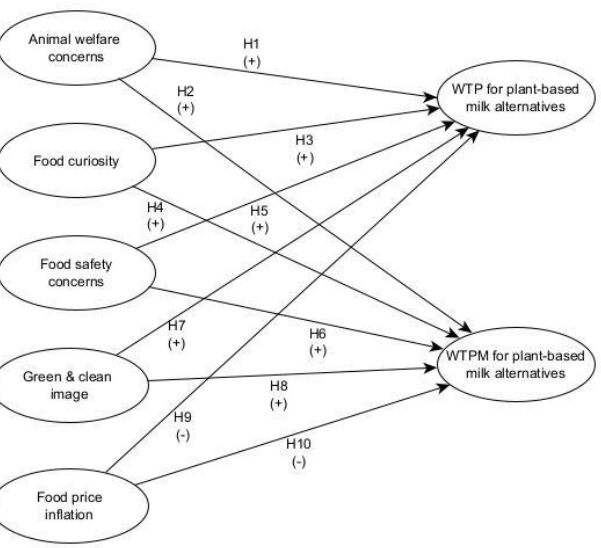
Figure 1. Proposed conceptual model. Note: Willingness to pay is abbreviated as WTP; Willingness to pay more is abbreviated as WTPM.